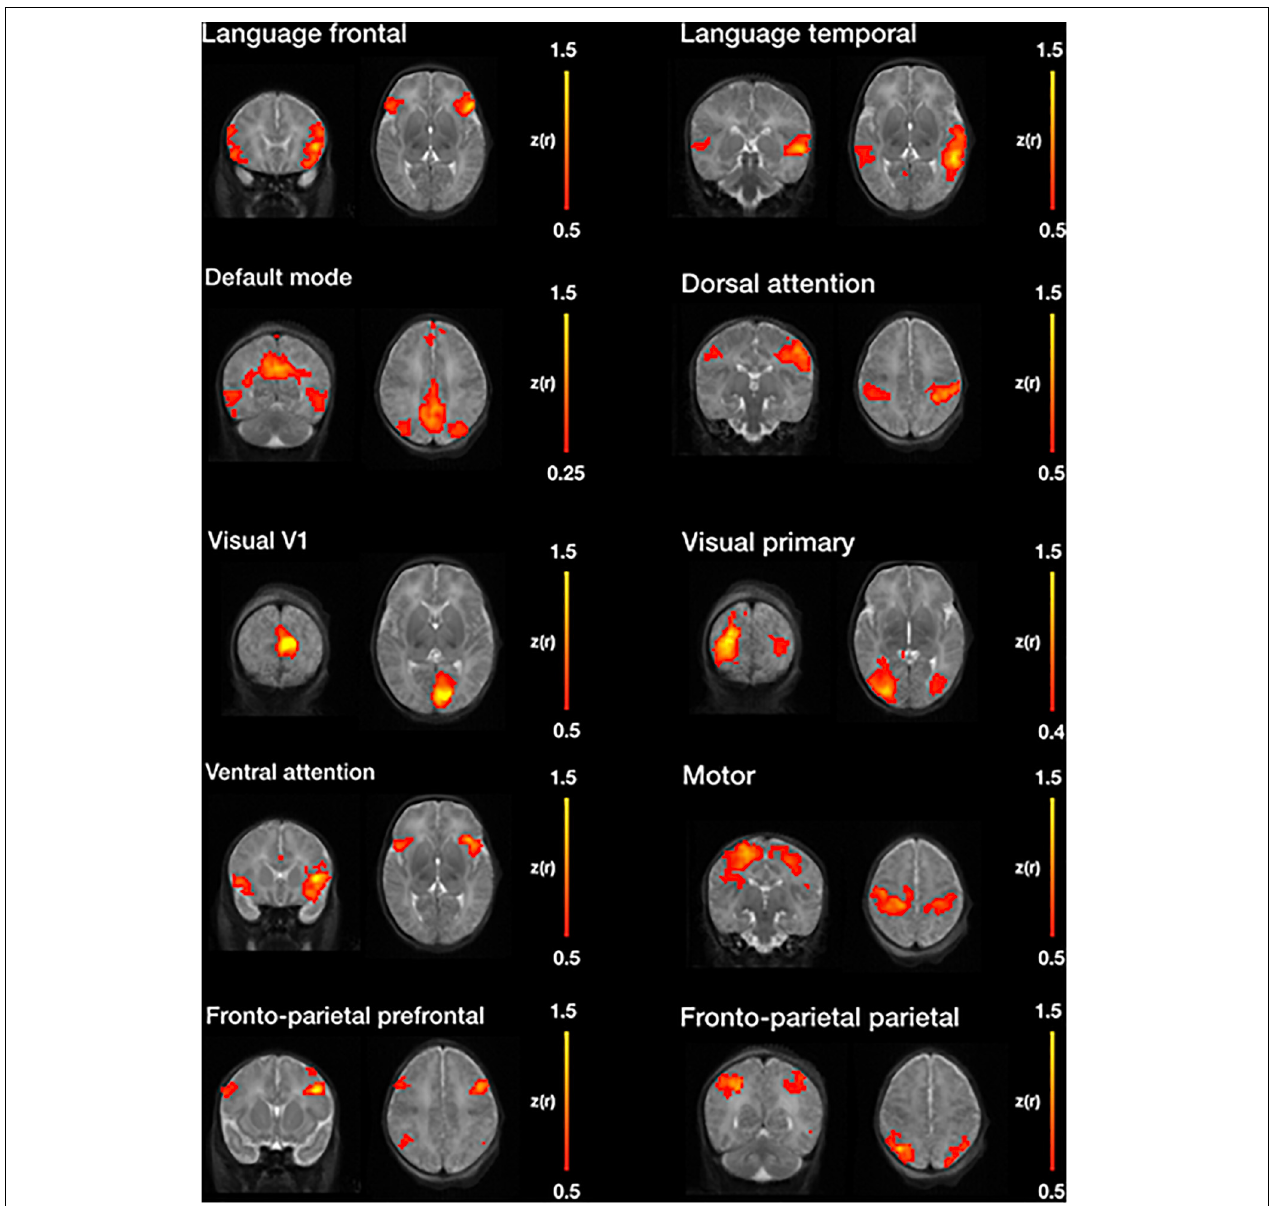
FIGURE 11 | Example resting state networks obtained by seed-based functional connectivity after image processing with